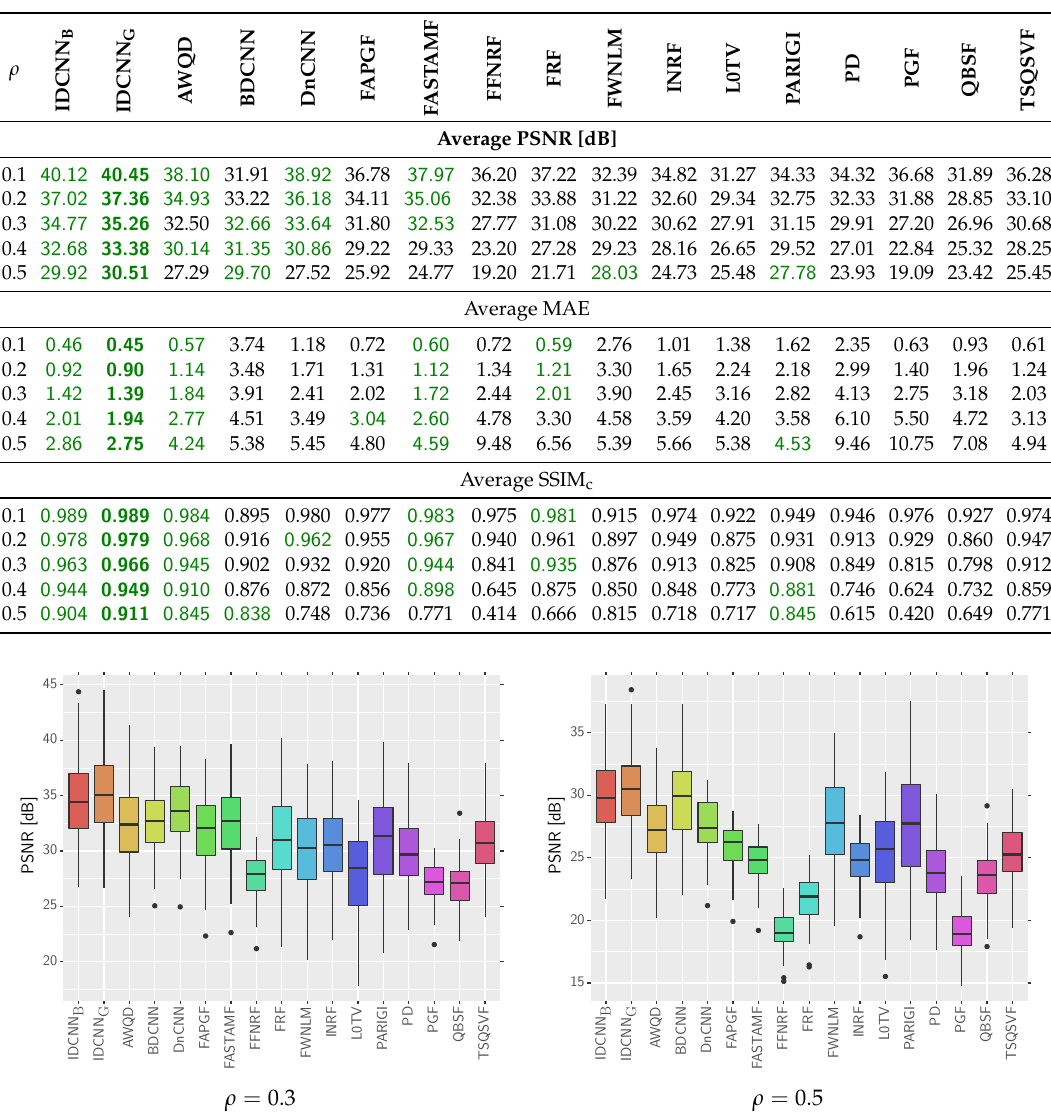
Table 7. Comparison of the denoising efficiency of the proposed network for impulsive noise removal with the state-of-the-art methods on the test dataset [36]. The result obtained with the most efficient filter are emboldened and 5 best results are highlighted with green color.